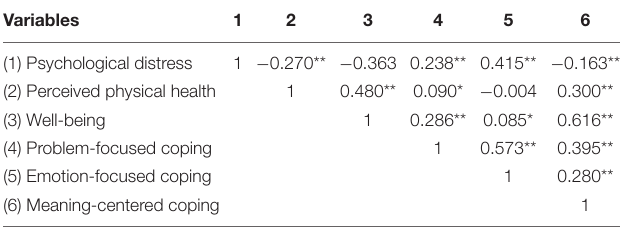
TABLE 2 | Correlation matrix for variables in the study ( n = 604).